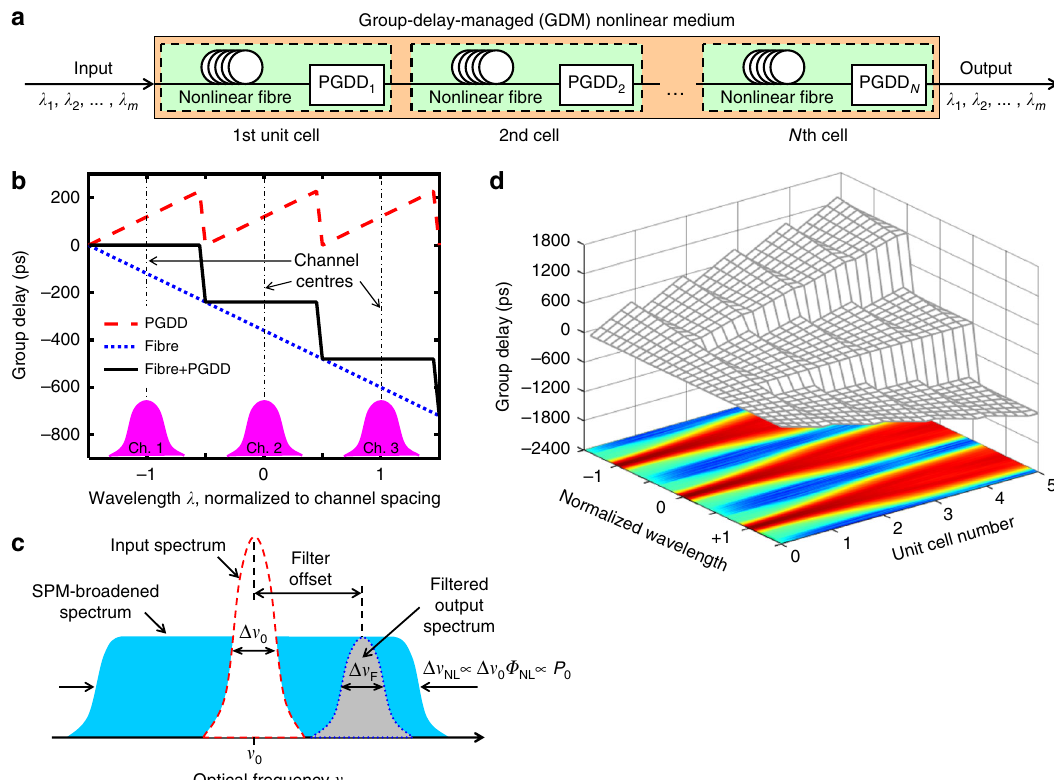
Fig. 1 Principle of multi-channel 2R regeneration. a Group-delay-managed (GDM) medium is made by concatenation of N ʽ fi bre + periodic group-delay device (PGDD) ʼ unit cells and processes m WDM channels. b Each cell has a staircase-like group-delay spectrum (whose derivative is dispersion), ensuring strong nonlinearity within each channel, but suppressed nonlinear interactions among the channels. Group-delay spectra are shown for three adjacent WDM channels. c Single-channel Mamyshev 2R regenerator is based on signal ’ s spectral broadening by self-phase modulation (SPM), followed by off-centre bandpass fi ltering. d Propagation in the GDM medium results in group-delay walk-off between the adjacent channels (wavelength is normalised to channel spacing) and allows their simultaneous broadening by the SPM without nonlinear inter-channel crosstalk. The coloured map underneath represents evolution of power spectral densities of the three channels. Group delay values in b , d assume the channel spacing of 200 GHz (1.6 nm) and fi bre with dispersion D = – 120 ps nm − 1 km − 1 and section length of 1.25